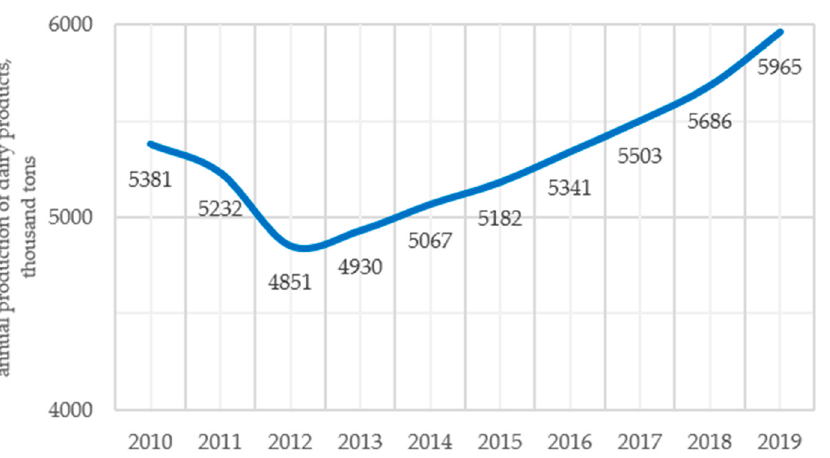
Figure 8. Production of milk and dairy products in the Republic of Kazakhstan for 2010–2019. Source: Stat.gov.kz, 2021. Available online: https://stat.gov.kz/ (accessed on 26 May